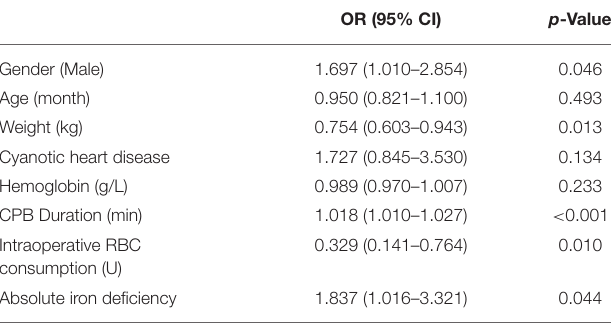
AID than those with FID and without ID. After